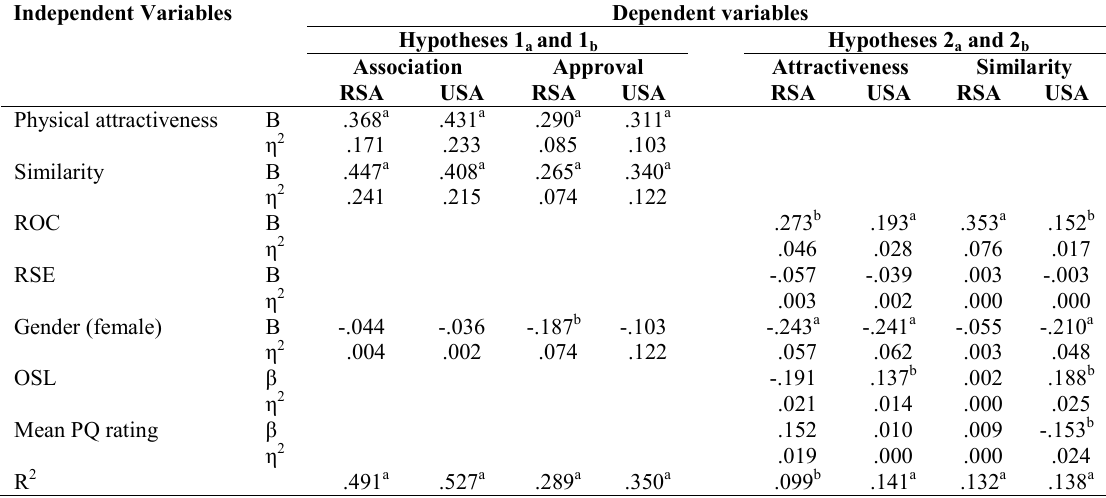
Table 2: Regression summaries